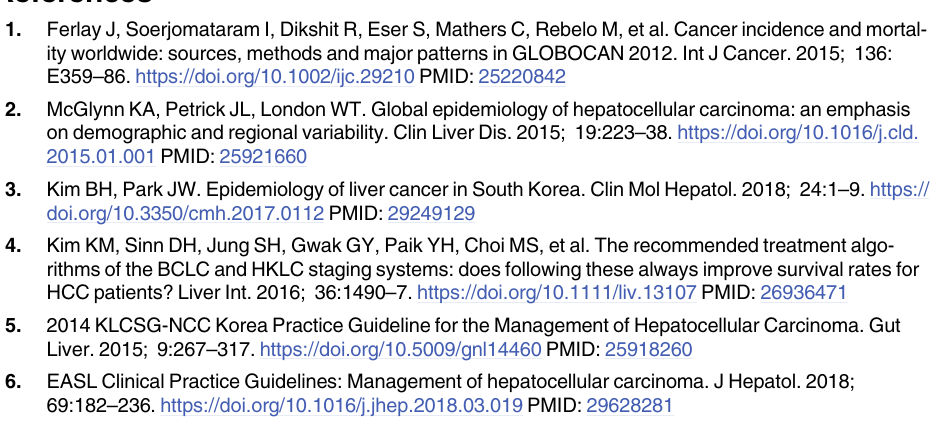
S1 Table. Hazard ratios (95% confidence intervals) for liver cancer specific mortality com- paring untreated vs. treated patients with newly diagnosed hepatocellular carcinoma, over- all and by SEER